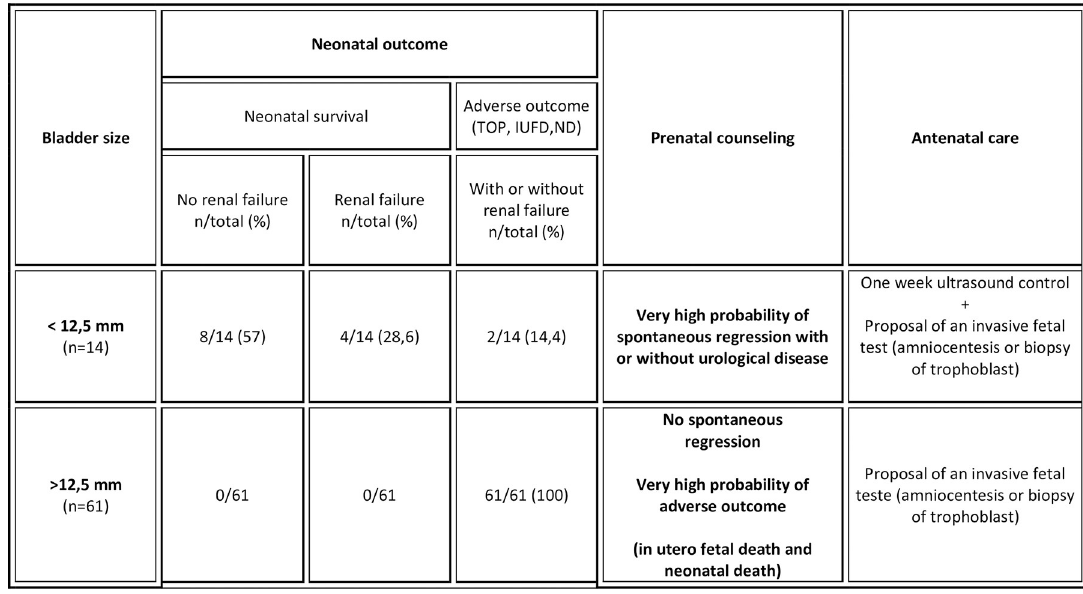
Fig 3. Decision analysis and prenatal counseling according to the bladder size “cut-off” determined by the area under the ROC curve. (TOP: termination of pregnancy; IUFD: in utero fetal death; ND: neonatal death).